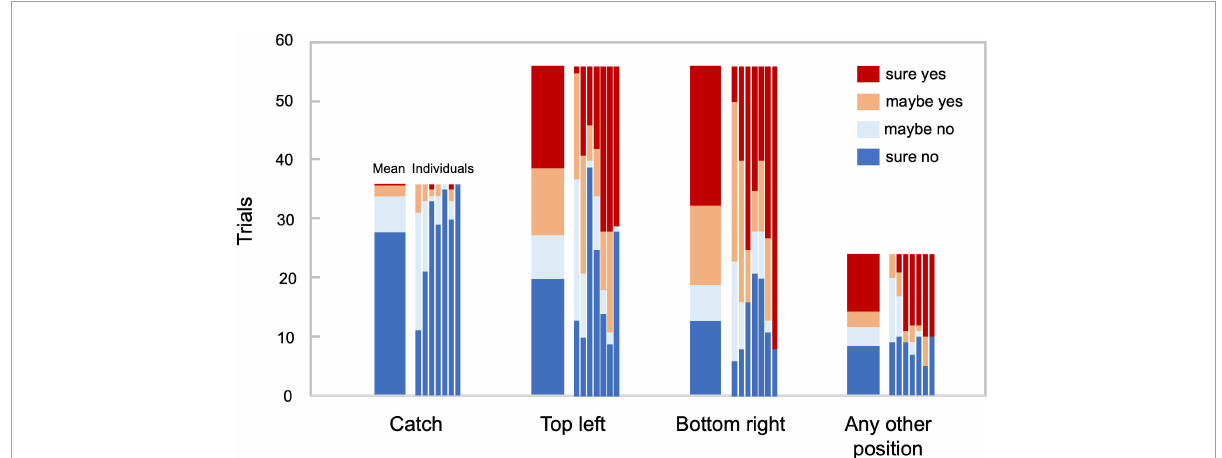
FIGURE2 Behavioral responses. Trial count for each behavioral response in 36 catch trials, 56 trials in which the target stimulus was presented at the top left and the bottom right, respectively, and the remaining 24 trials, in which the target stimulus was presented at any other position. The adjacent bars correspond to average and individual responses, respectively ( N = 7).